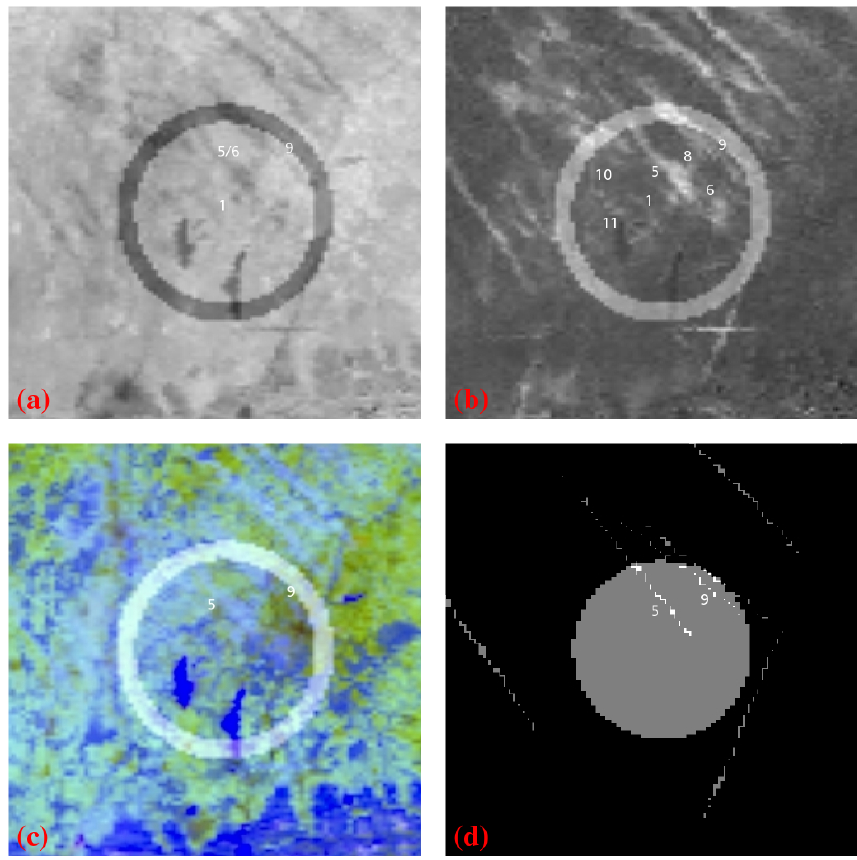
Fig. 2. Contrail scene of 16 April 2007, 12:02UTC, as observed by the AVHHR instrument. All the image types used in this study are shown together with the result of the CDA. The corresponding Wolkam pictures are shown in Fig. 1. The Wolkam field of view is marked in all satellite pictures with a circle. (a) AVHRR channel 5 brightness temperatures. (b) AVHRR brightness temperature differences between channel 4 and channel 5. (c) AVHRR false colour composite. (d) Contrails detected by CDA: in grey outside of the Wolkam field of view, in white inside. The small numbers inside every panel indicate which contrails from Fig. 1b could be detected in the corresponding AVHRR